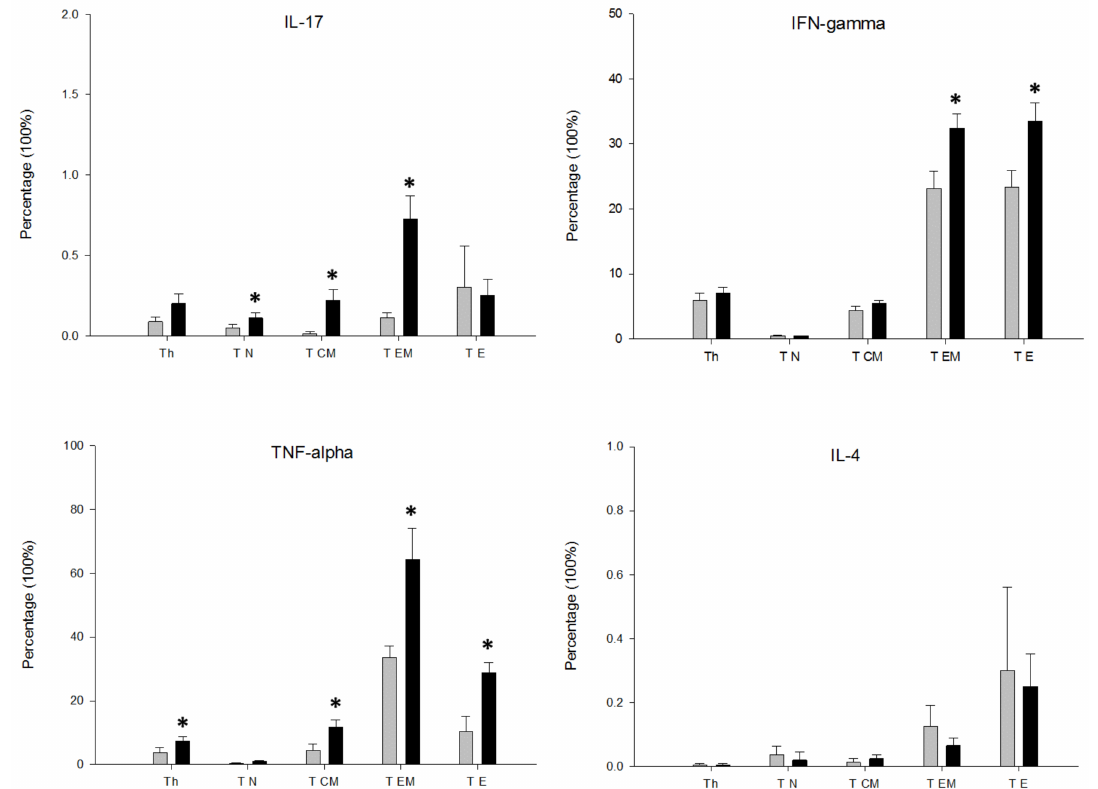
Figure 2. Percentage of IL-17A, IFN γ , TNF-alpha and IL-4 expression by total circulating CD4 + T lymphocytes and T N , T CM , T EM and T E subsets in MDD patients and healthy controls after stimulation with PMA. Percentage of cells (y axis) that express the indicated cytokine by total CD4 + T lymphocytes and their T N , T CM , T EM and T E subsets (x axis) in MDD patients (black rectangles plots) and HCs (gray rectangles plots). * Significant difference between MDD and HCs for the indicated